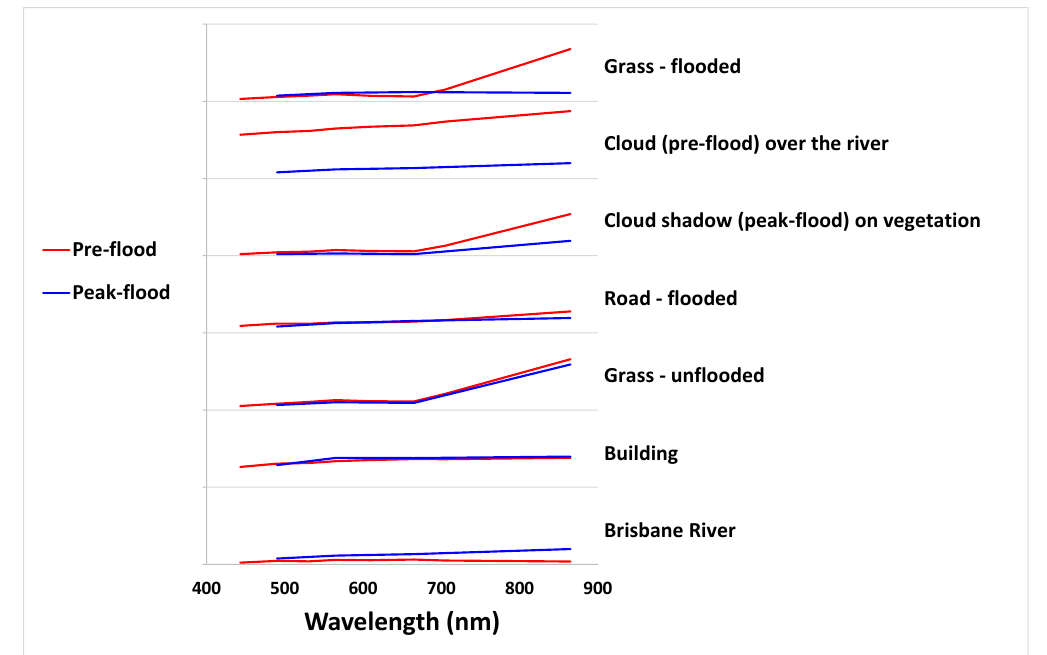
Figure 4. Representative spectra over flooded and unflooded sites, comparing data from the pre- flood 8-band PlanetScope image (9 February 2022) and the peak-flood 4-band PlanetScope image (28 February 2022).